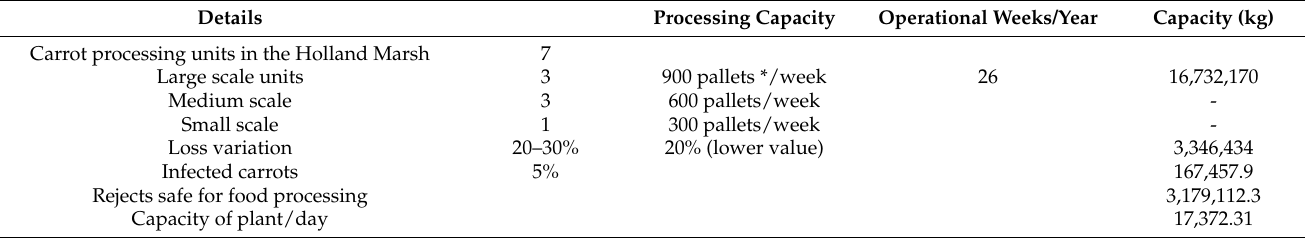
Table 1. Estimation of the carrot rejects/waste generated in the Holland